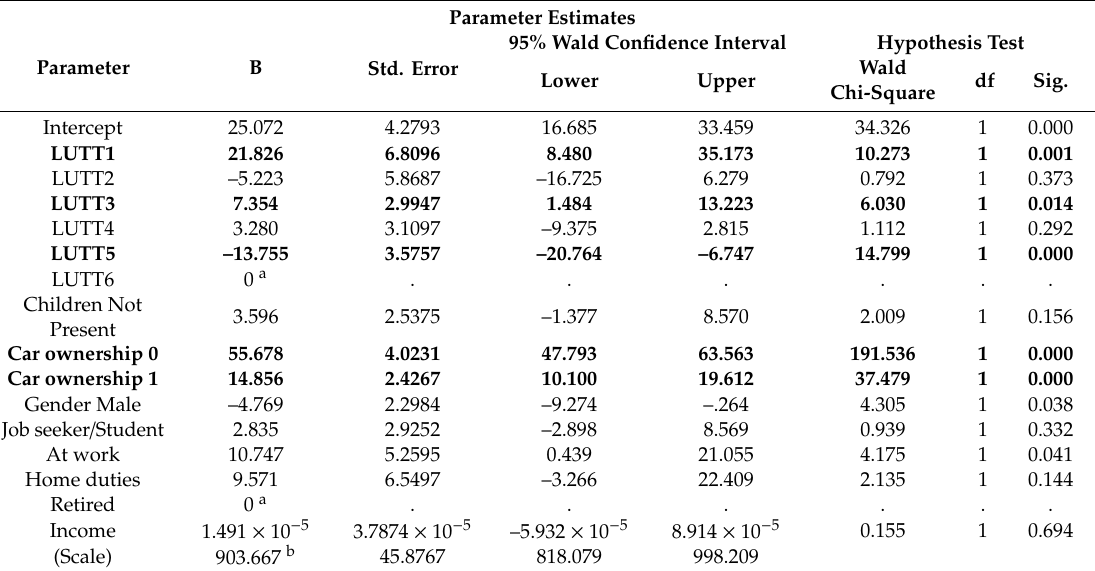
Table 8. Parameter Estimates for the Model, with Significant Values shown in Bold